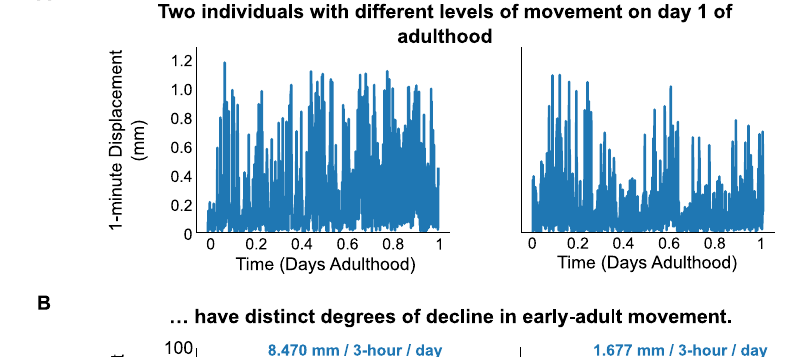
PLOS ONE | https://doi.org/10.1371/journal.pone.0257591 February 2,